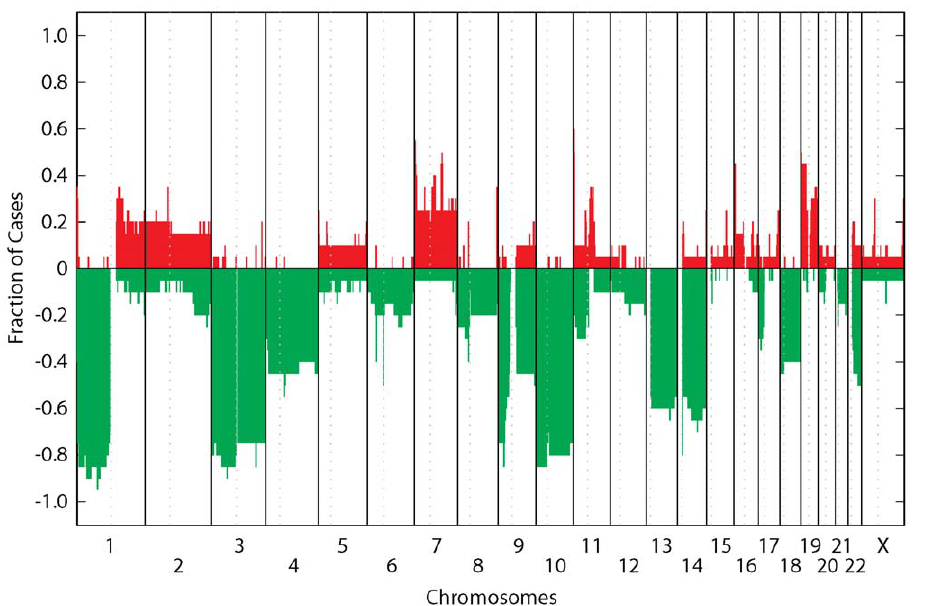
Figure 2. Frequency plot by genomic position. Array CGH data from all chordoma cases from 20 unique patients were combined and presented as copy number gain/loss frequencies relative to chromosome and genomic position. Note that chromosome Y is not depicted. The second recurrent CH37 tumor was excluded from analysis.